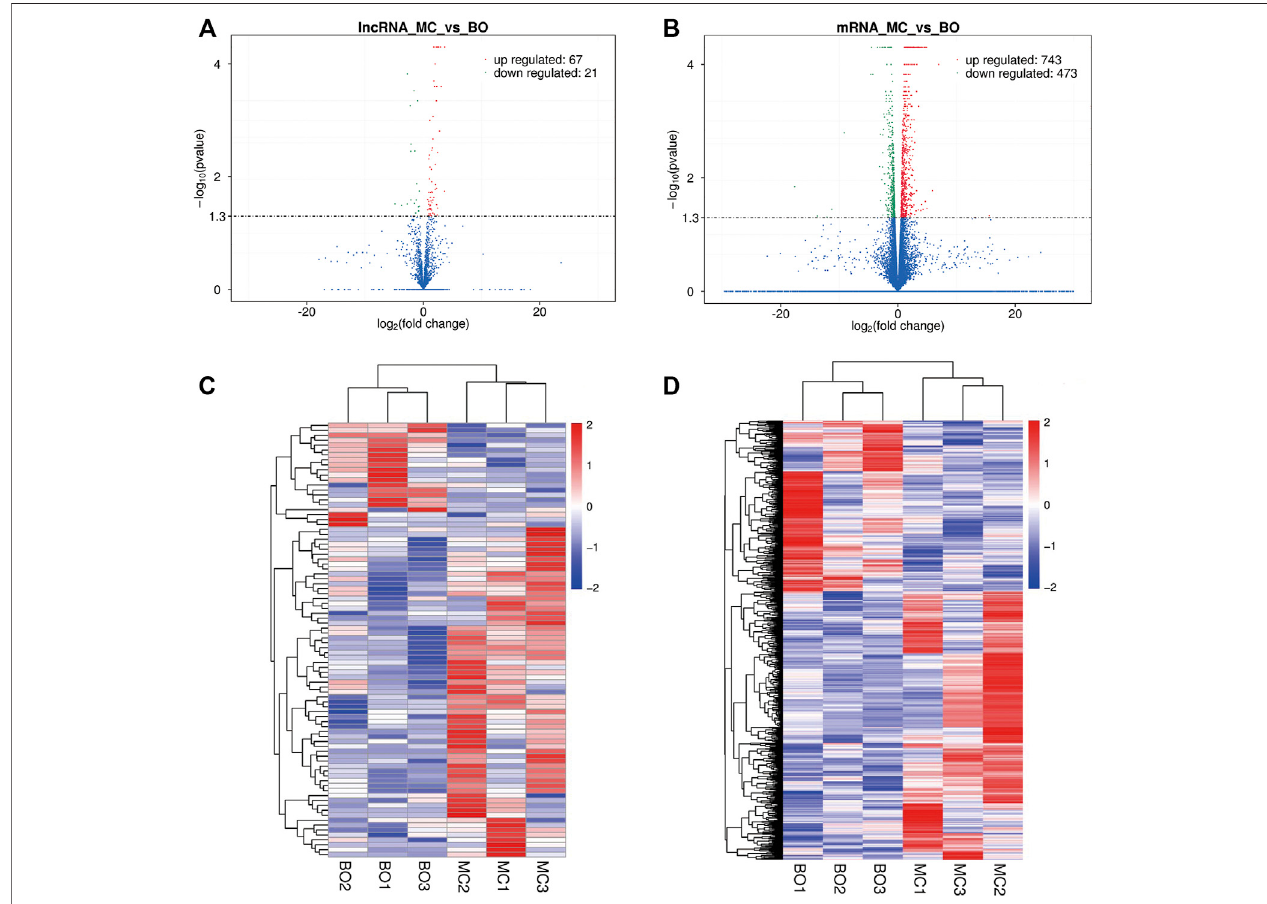
FIGURE2 | Differential expression oflncRNAs and mRNAsin the pre-ovulatoryfollicles ofgoats. (A,B) Volcano plots ofdifferentially expressed lncRNA and mRNA transcripts. (C,D) Hierarchical clustering of the expression pro fi les of differentially expressed lncRNAs and mRNAs.